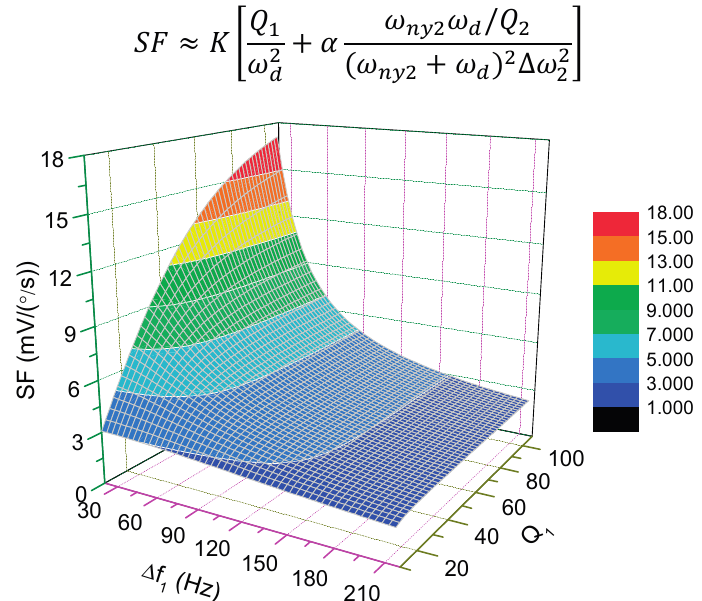
and (cid:1843) (cid:2869) (cid:2869)